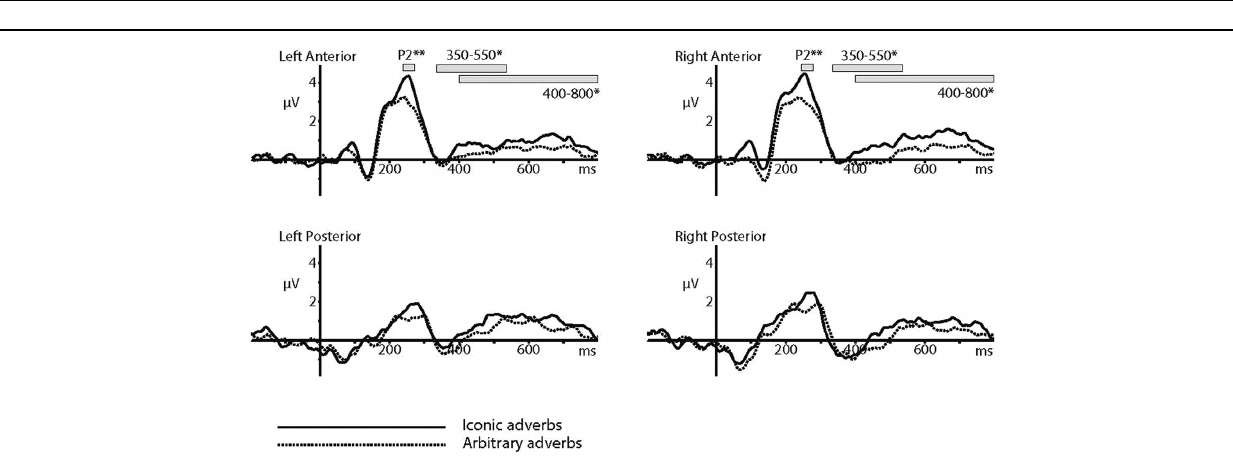
FIGURE 3 | Event-related potentials in response to iconic and arbitrary adverbs – 4